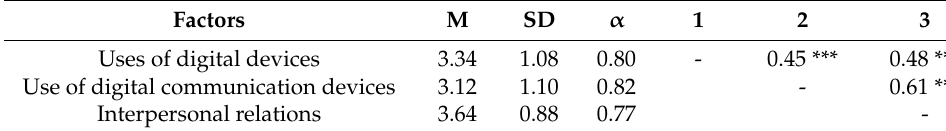
Table 2. Preliminary analysis.